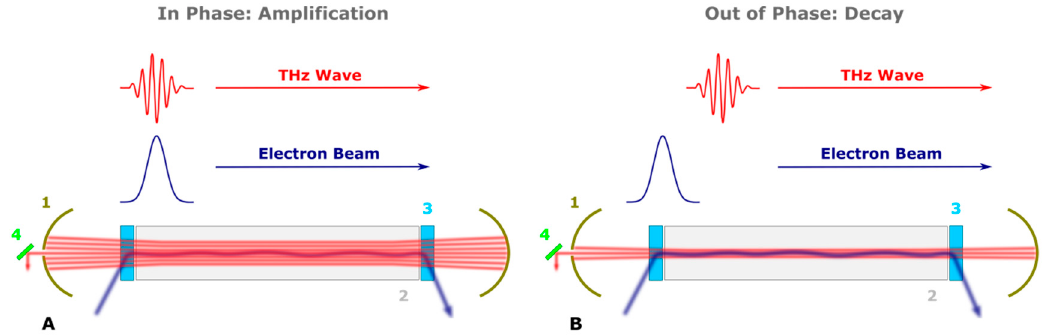
Figure 3. Schematic representation of THz radiation amplification ( A ) or suppression ( B ). The latter is achieved by periodic shift of the phase of the electron bunch injection. The numbers show optical resonator (1), undulator (2), dipole magnets (3) and THz radiation output (4).